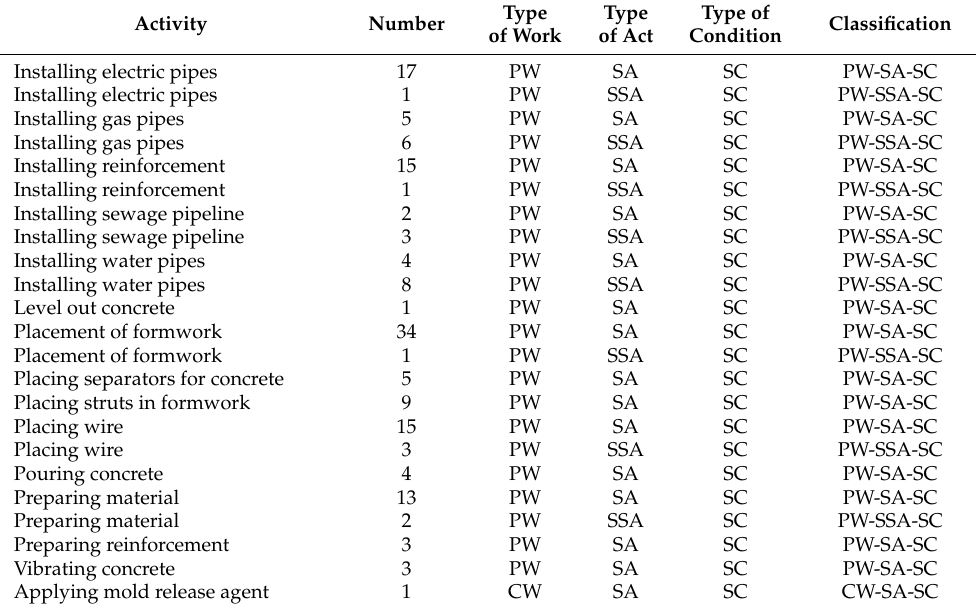
Table 7. Work sampling based on the new classification after corrective